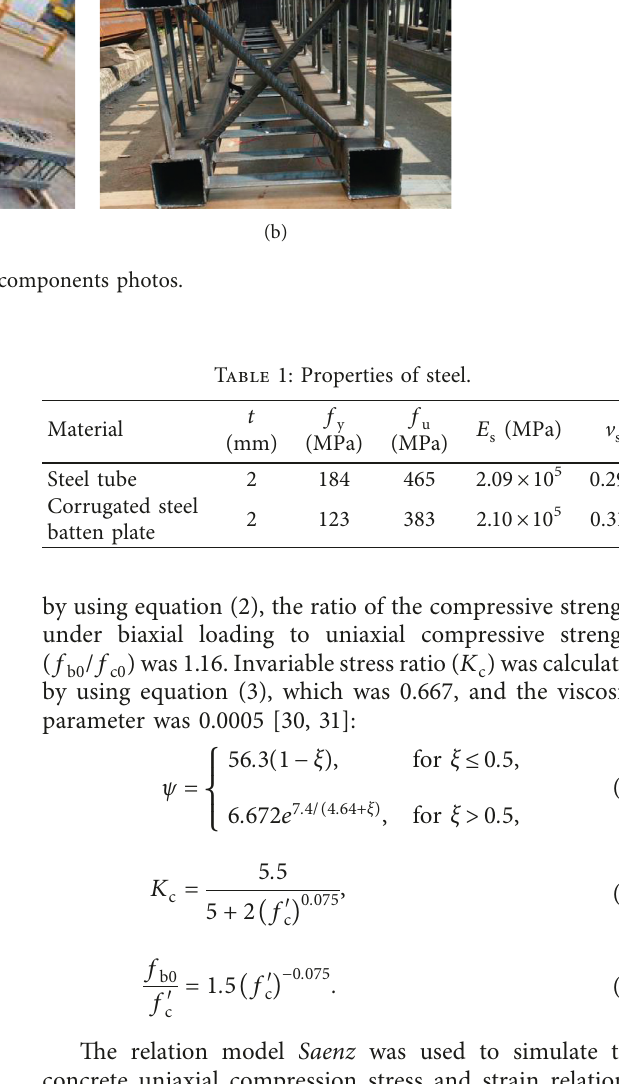
Figure 4: Waveform design of the corrugated steel plate.